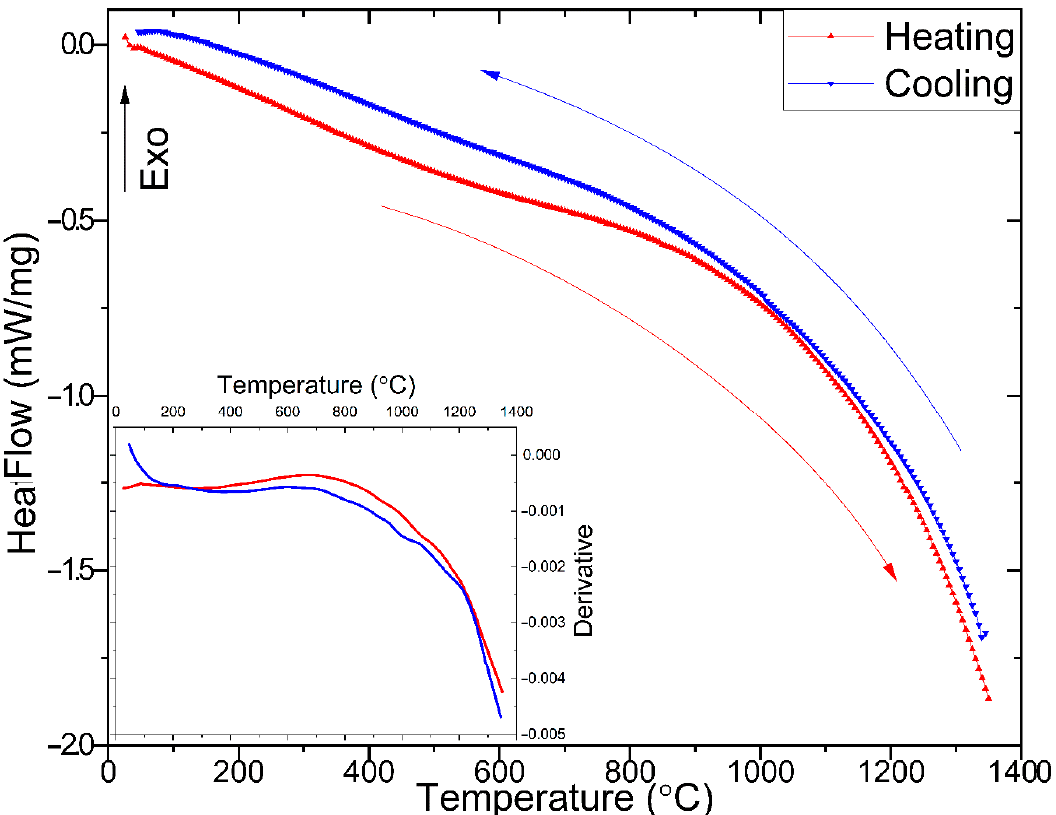
Figure 5. Differential scanning calorimetry (DSC) heating/cooling curves for the studied alloy. Figure 5. Di ff erential scanning calorimetry (DSC) heating / cooling curves for the studied